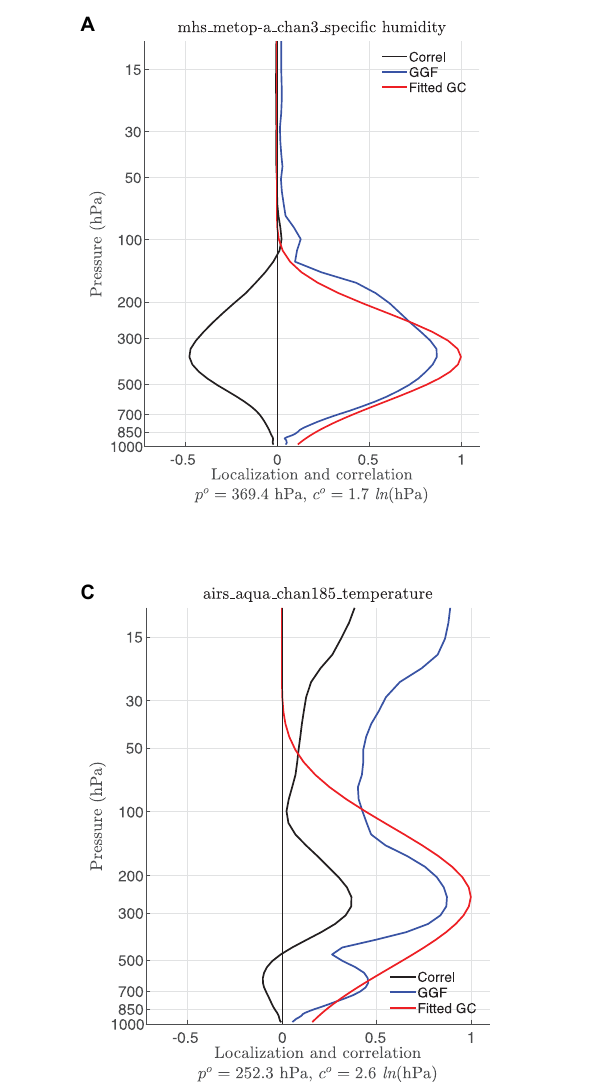
experiment, including four cycles before the rapid intensification of typhoon Yutu (from 0000 UTC 22 October to 1800 UTC and associated localization parameters of experiment GGF-Time are estimated along with the assimilation cycle and updated every 6 h. To eliminate the impact of diffusion closed to the model top, sample correlations above 30 hPa are not used to fit the GC function, and the default localization parameters are used for radiances whose vertical locations are above 30 hPa. The GGF localization functions and localization parameters are computed for each channel of every satellite platform with state variables of temperature and specific humidity. The